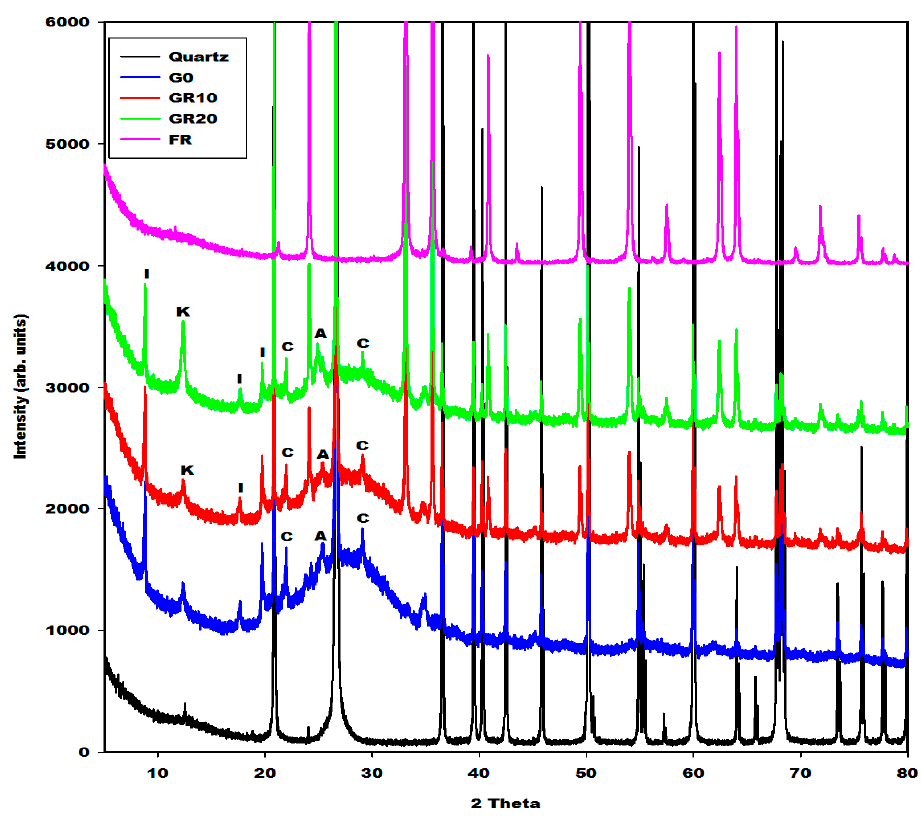
Figure 5. X-ray patterns of geopolymer materials (G0, GR10, GR20, quartz and FR: Hematite). I, K, A and C denotes the peaks of illite, kaolinite, anatase and cristobalite, respectively.